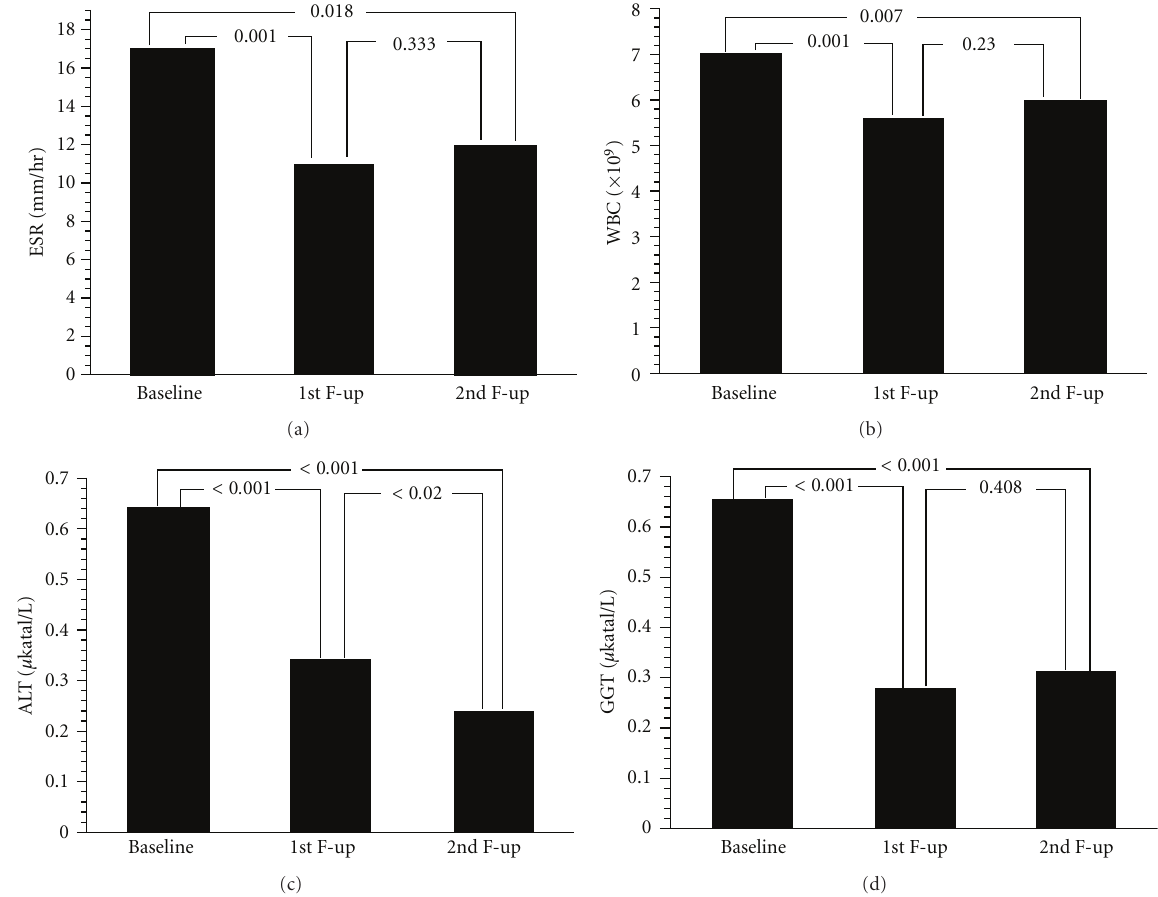
Figure 1: The changes in erythrocyte sedimentation rate (ESR) (a), white blood cell (WBC) count (b), serum alanine aminotransferase (ALT) (c), and gamma-glutamyl transferase (GGT) (d) concentrations are shown at baseline and at 1st followup (1 year) and 2nd followup (3.5 years) after Roux-en-Y gastric bypass surgery. Mean values are shown. Statistical significance indicated by P values. F-up denotes